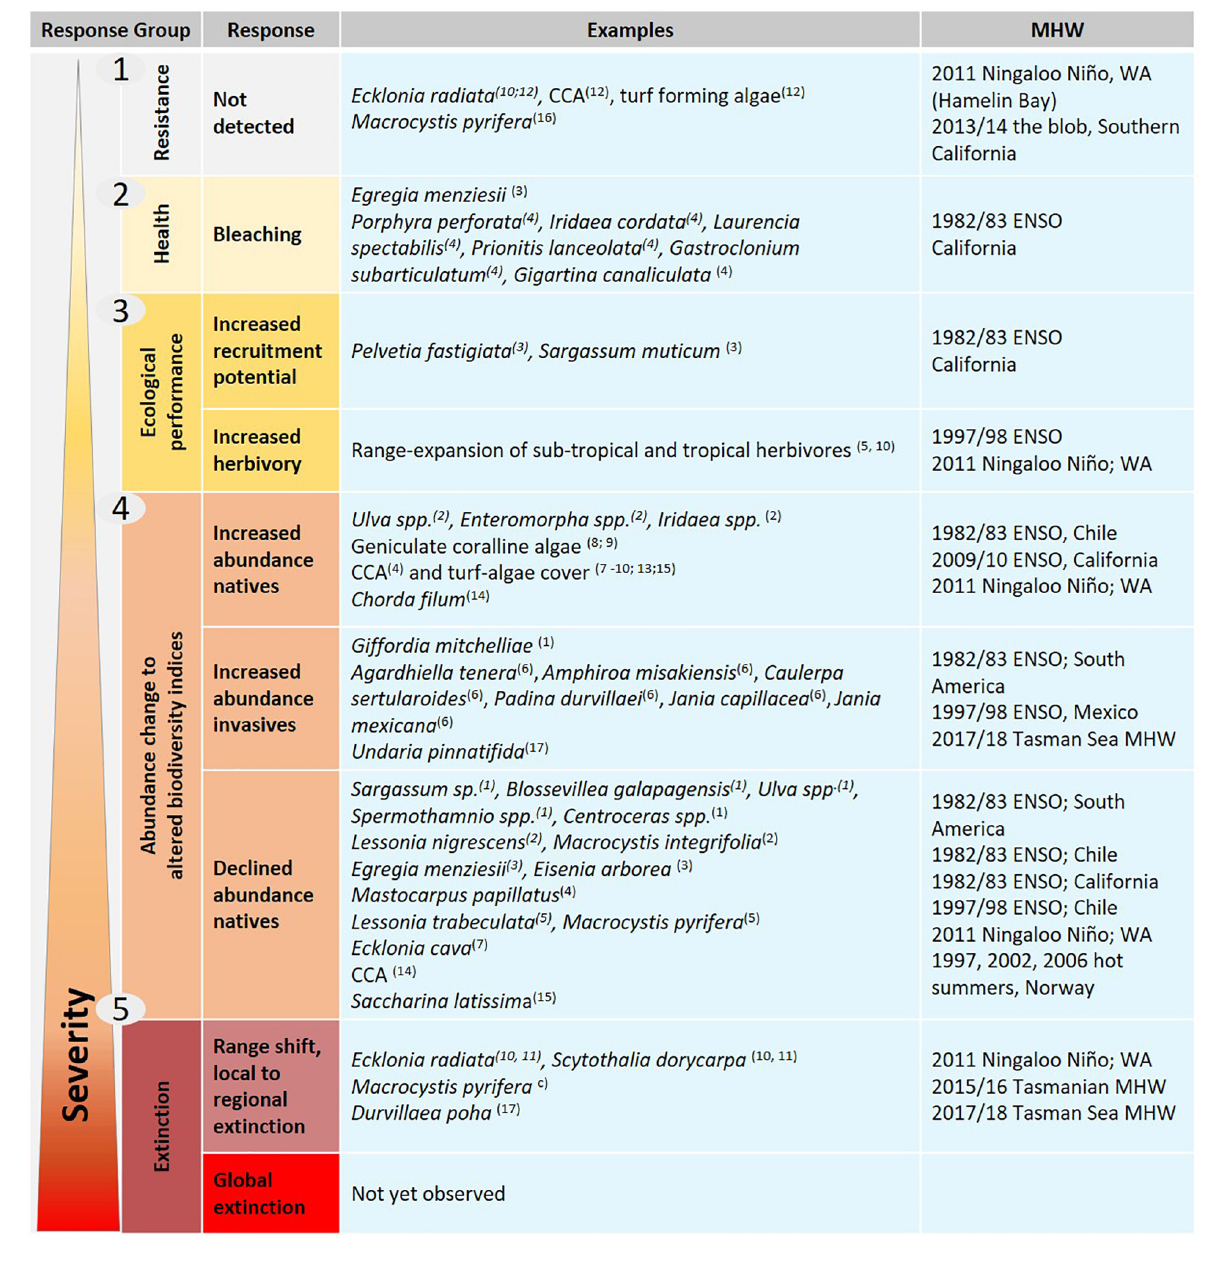
FIGURE 1 | Schematic of different responses of seaweeds with examples to MHWs grouped by severity of the observed response, from no observed effect (e.g., resistance) and less severe impact (e.g., tissue bleaching) at the top , to more severe impacts (e.g., local to global extinctions) at the bottom . Number/letter in brackets refer to Table 1 . Several species have multiple observations as their responses differed between locations, e.g., resistance, abundance decline, and regional extinction were observed for Ecklonia radiata and Scytothalia dorycarpa along the latitudinal gradient in Western